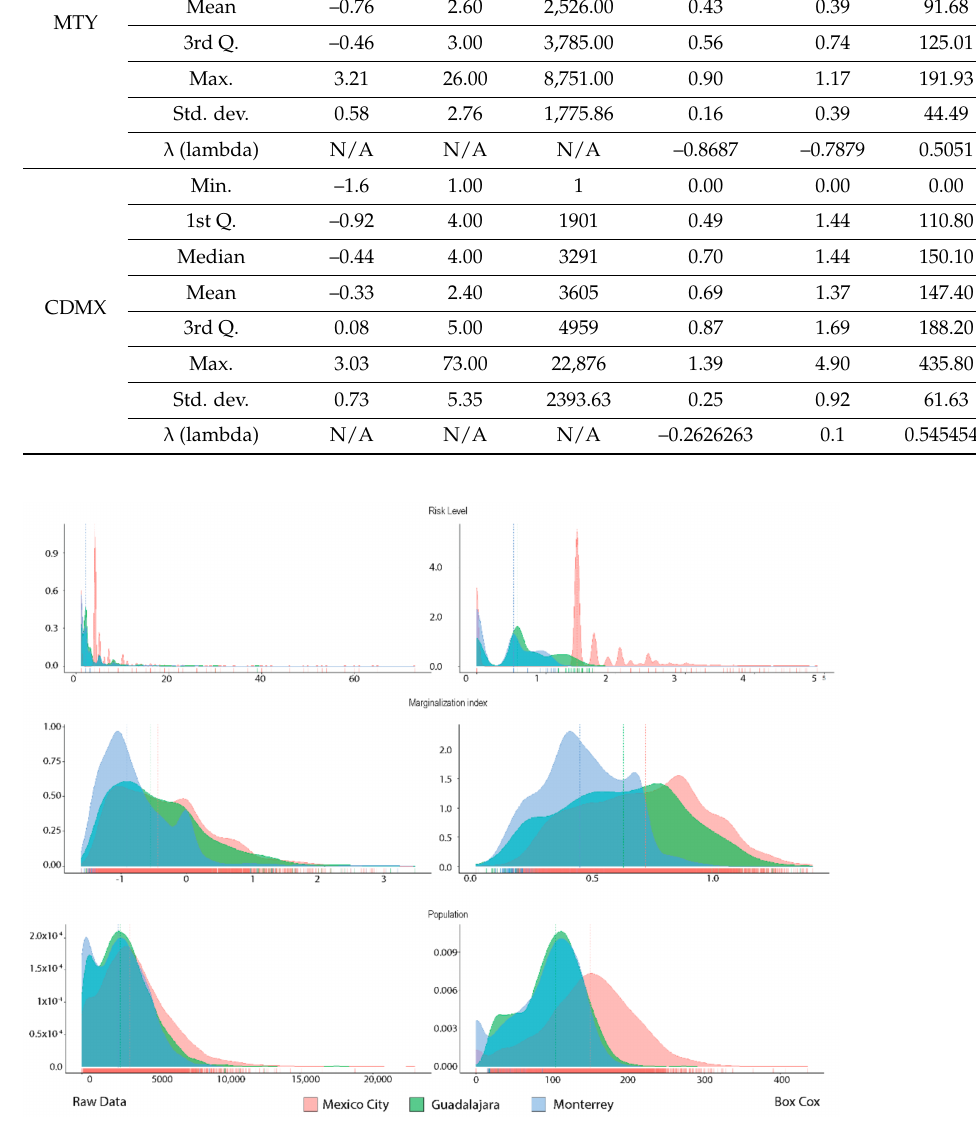
Figure 1. Raw and transformed data for risk level, marginalization index, and